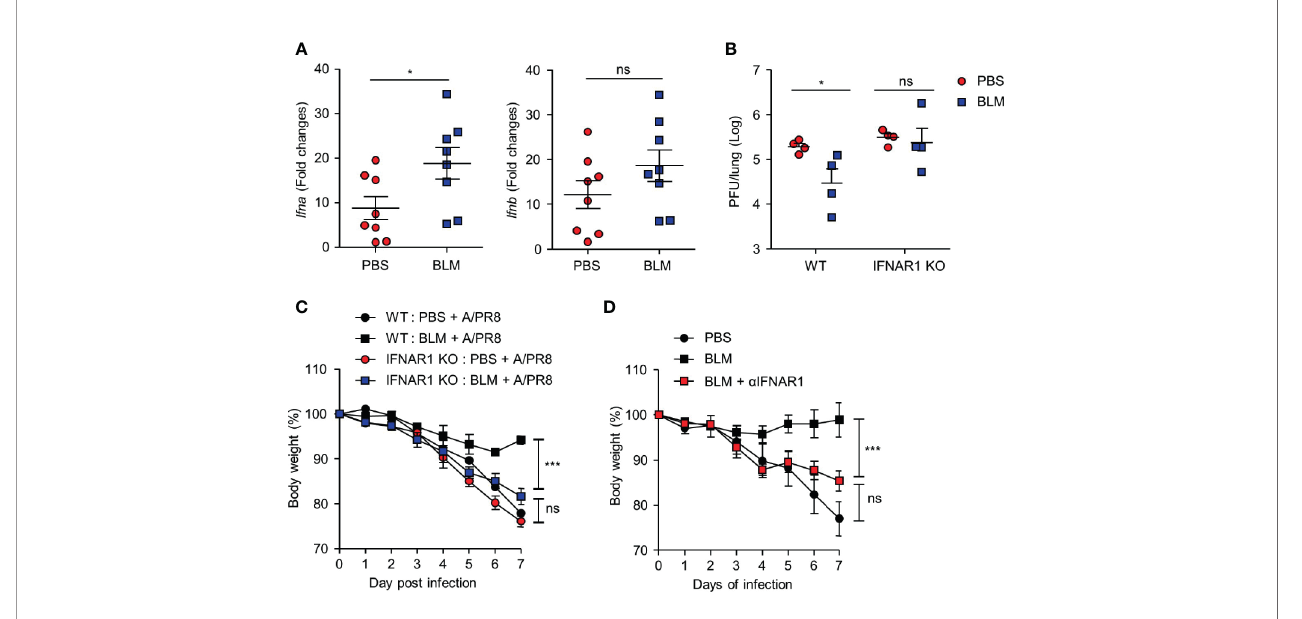
FIGURE 3 | BLM treatment enables antiviral effects via an IFN- a -dependent manner. BLM-administered mice were intranasally infected with lethal doses and sacri fi ced after 1 or 2 days post infection (d.p.i.) (A) Measurement of host Ifna4 and Ifnb1 mRNA at 1 d.p.i. by qRT-PCR ( ● , n = 8; ■ , n = 8). (B) Viral activity of lung tissue from BLM-treated wild type (WT) and IFNAR1 -/- mice infected with a lethal dose at 2 d.p.i. using the A549 cell line ( ● ; n = 4, ■ ; n = 4). (C) BLM-treated WT and IFNAR1 -/- mice were infected with 1 × 10 3 PFU and body weight was monitored for 7 days ( ● , n = 2; ■ , n = 2; ● ;, n = 6; ■ , n = 8). (D) a IFNAR1 was administered at -1, 2, and 5 d.p.i., and mice were infected with sub-lethal virus dose, and body weight monitored for 7 days ( ● , n = 3; ■ , n = 3; ■ , n = 4). Data are expressed as mean ± SEM of representative of 1 experiment for (B, D) and 2 independent experiments for (A, C) . Statistical analysis was performed for (A, B) using t-tests and in (C, D) by Two-way ANOVA (* p < 0.05, *** p < 0.001). ns, not signi fi